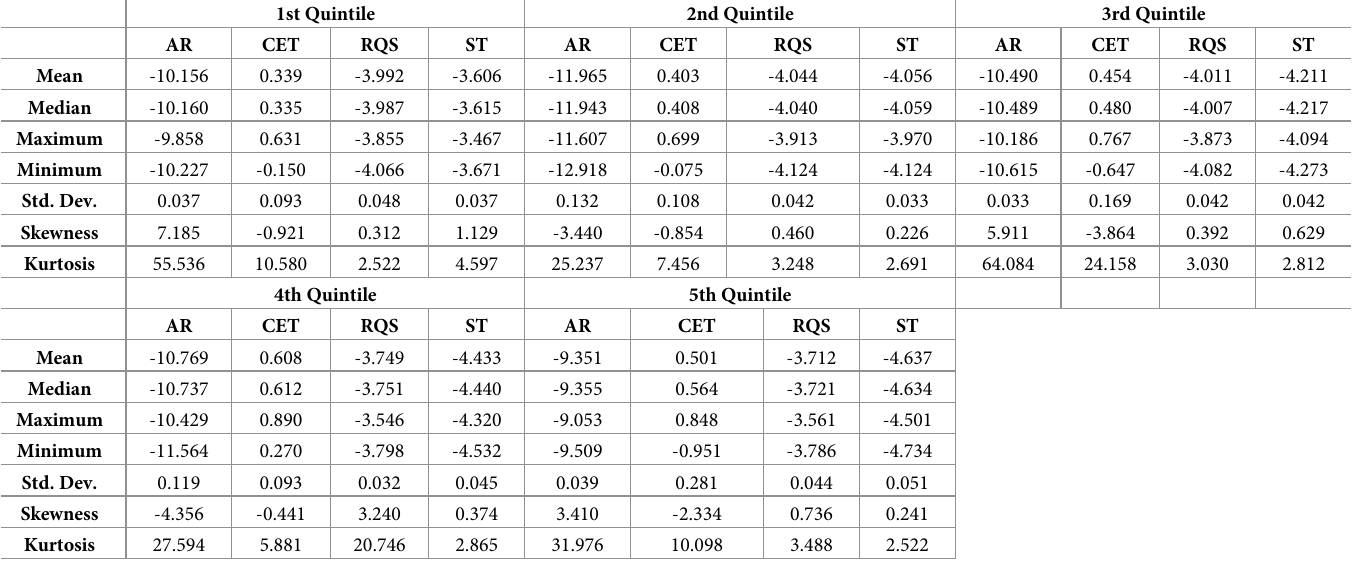
Table 2. Descriptive statistics of the liquidity measures for quintile groups.